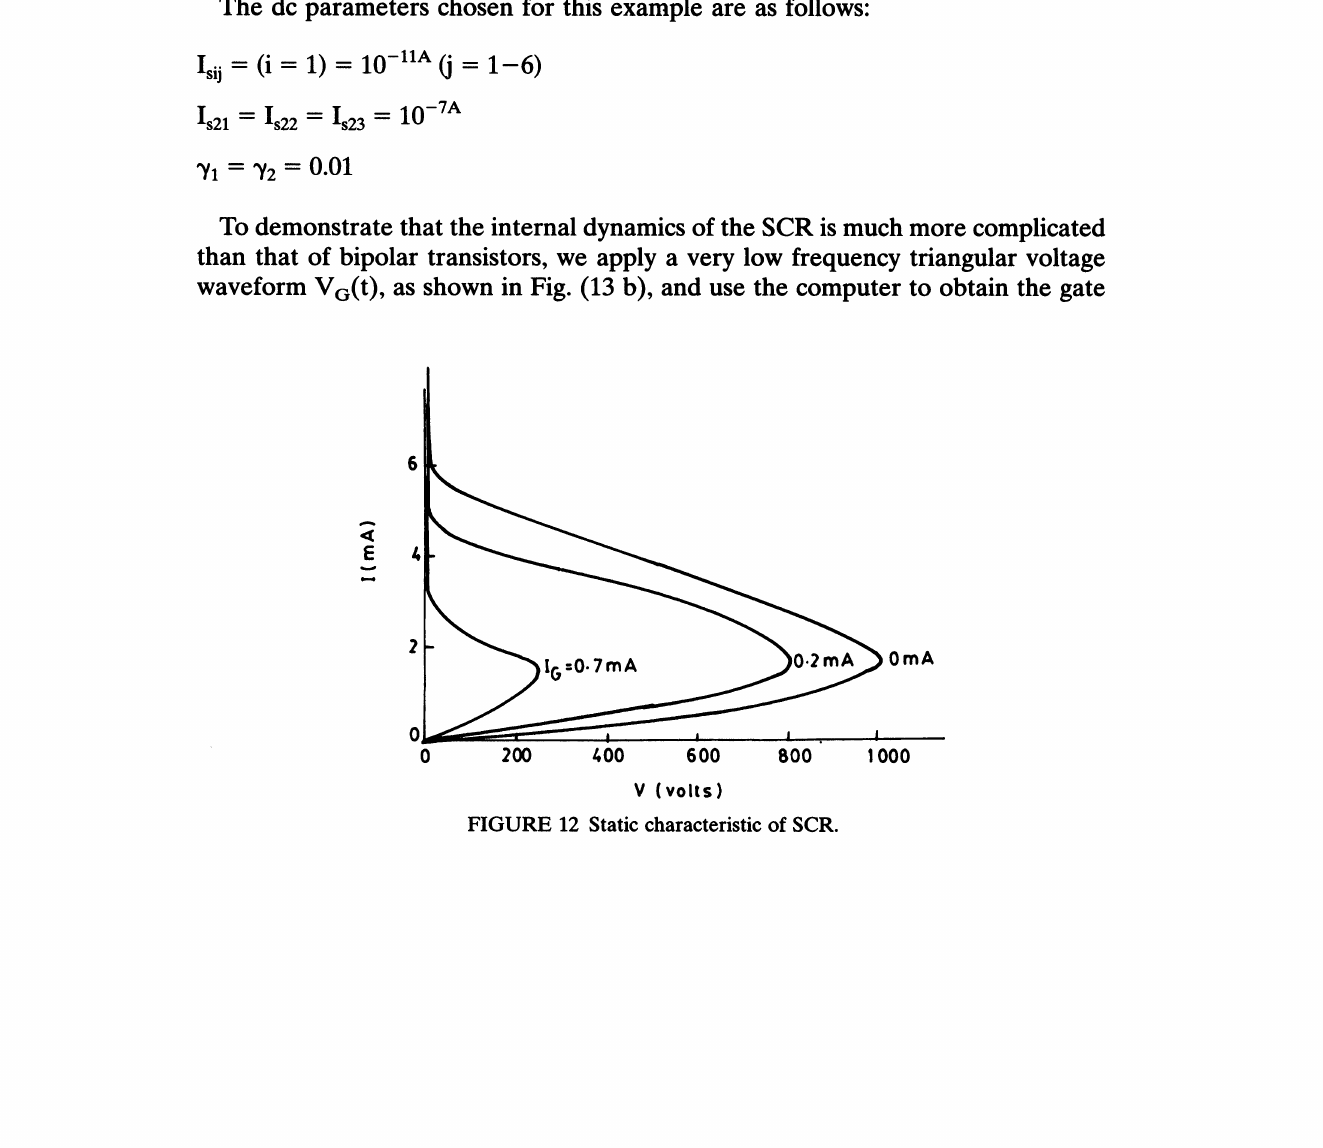
FIGURE 12 Static characteristic of